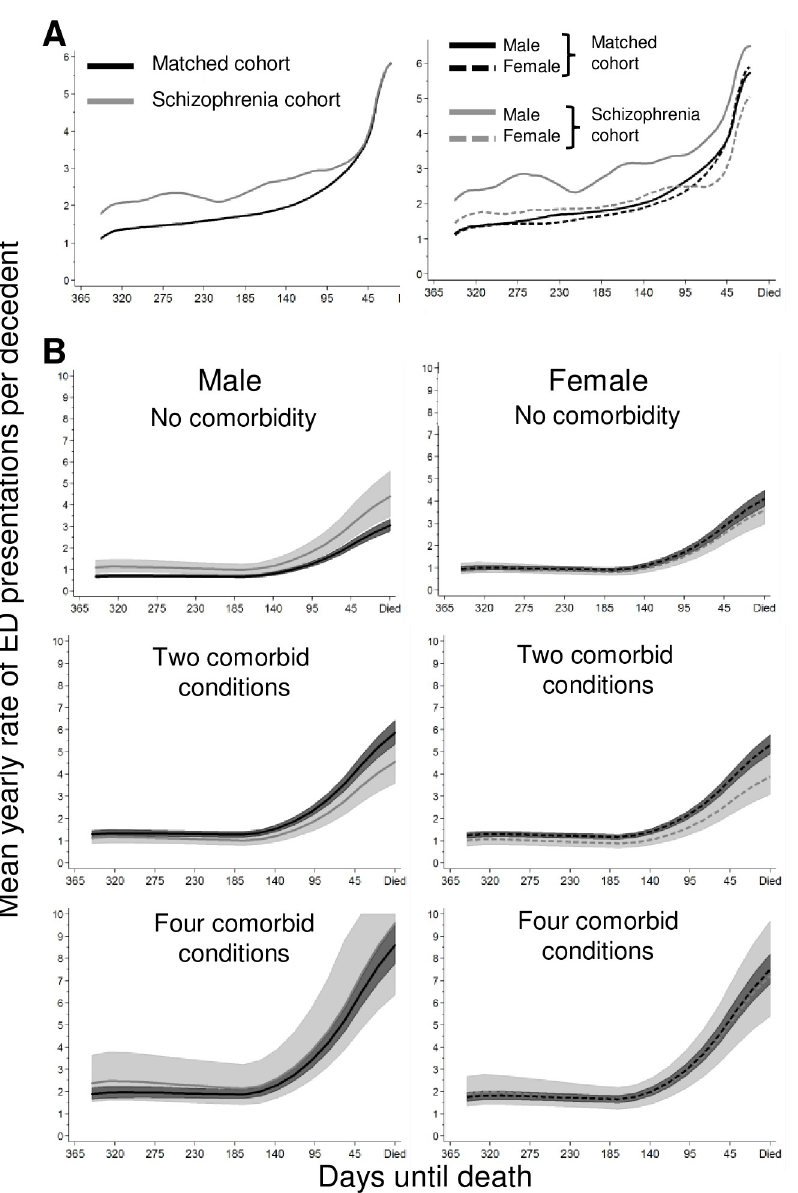
Fig 1. The average yearly (hazard) rate of ED presentations per decedent over the last year of life for the schizophrenia and matched cohorts and stratified by sex, estimated from A) an unadjusted kernel-weighted estimator of the hazard and B) an adjusted flexible parametric proportional hazards model. Values in B) predicted for Australian born non-Indigenous decedents living in a metropolitan area of average disadvantage without a partner, and aged 50 years or older at death. Sex and comorbidity were entered as interaction